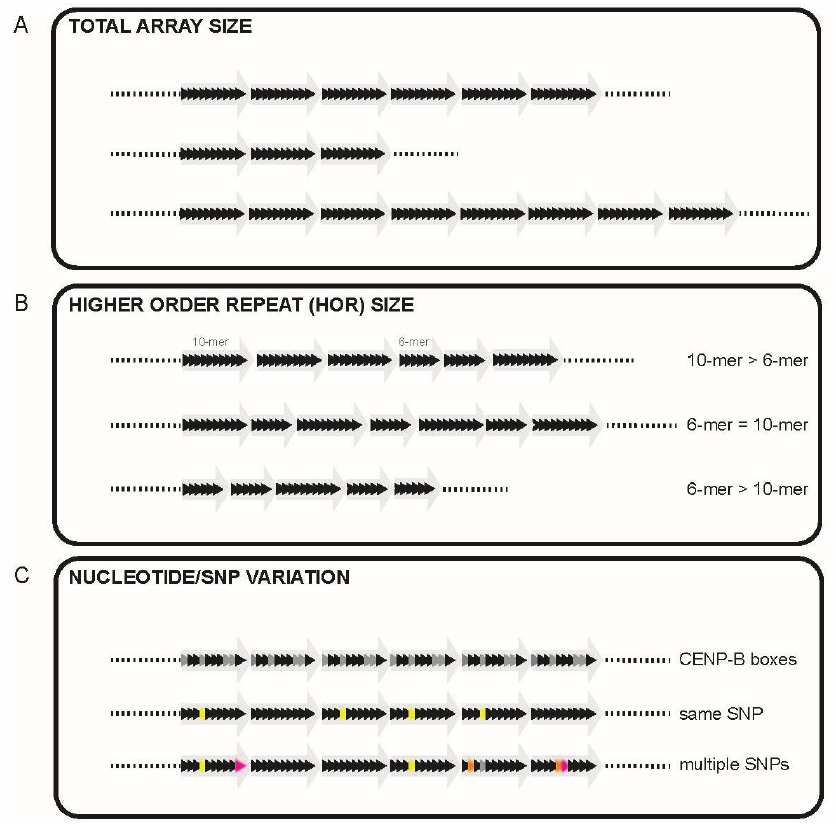
Figure 2. Heterogeneity of alpha satellite DNA. The alpha satellite DNA at centromeres exhibits several types of polymorphism. ( A ) Total array size, defined by the number of higher order repeats (HOR; gray arrows), varies between homologues and among individuals; ( B ) The same alpha satellite array from a given chromosome type can contain HORs of different sizes. In addition, the number of each HOR variant can vary. For example, an alpha satellite array can contain a mixture of 10-mers and 6-mers, with a greater number of 10-mers. Another array from the same chromosome in a different individual might have an equal number of 10-mers and 6-mers or, alternatively, more 6-mers than 10-mers; ( C ) Alpha satellite DNA can also vary at the level of monomer (black arrowheads) type and arrangement. Some monomers (gray arrowheads) contain a specific sequence element called the CENP-B box. Others monomers can contain identical nucleotide changes or SNPs (yellow arrowheads) within the same array. Multiple SNPs (hot pink, orange, gray, yellow arrowheads) can be present in the same HOR or distributed across an alpha satellite array. Each type of variation (array size, HOR size, SNPs) is not mutually exclusive and all contribute to the heterogeneity of alpha satellite DNA in the human